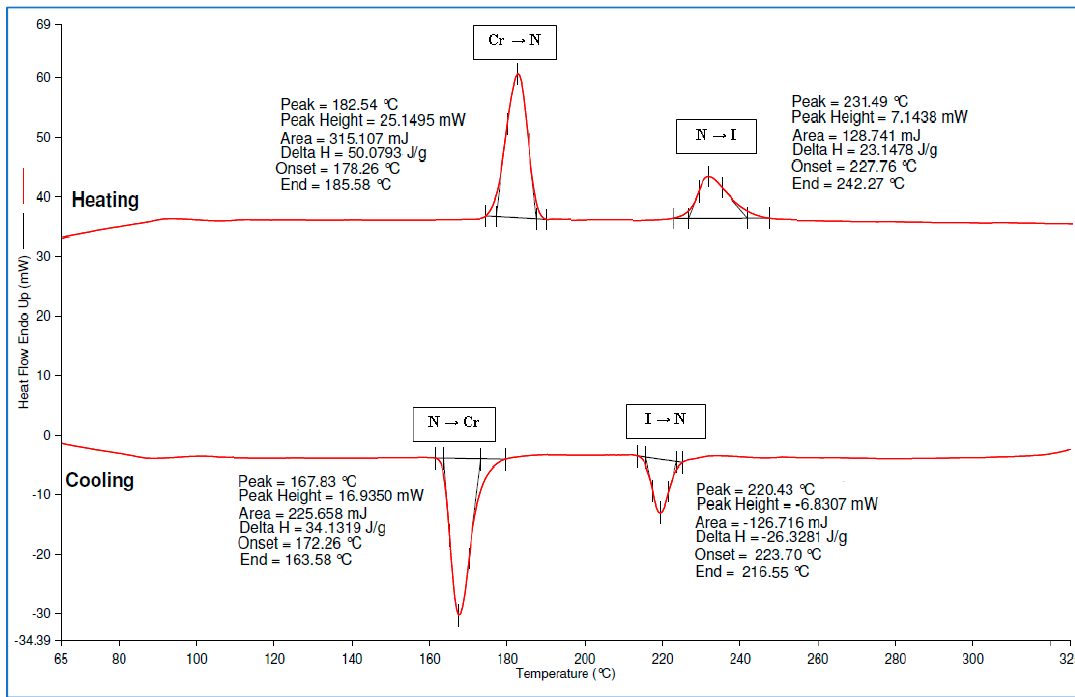
Figure 13. DSC thermogram of compound 4f .